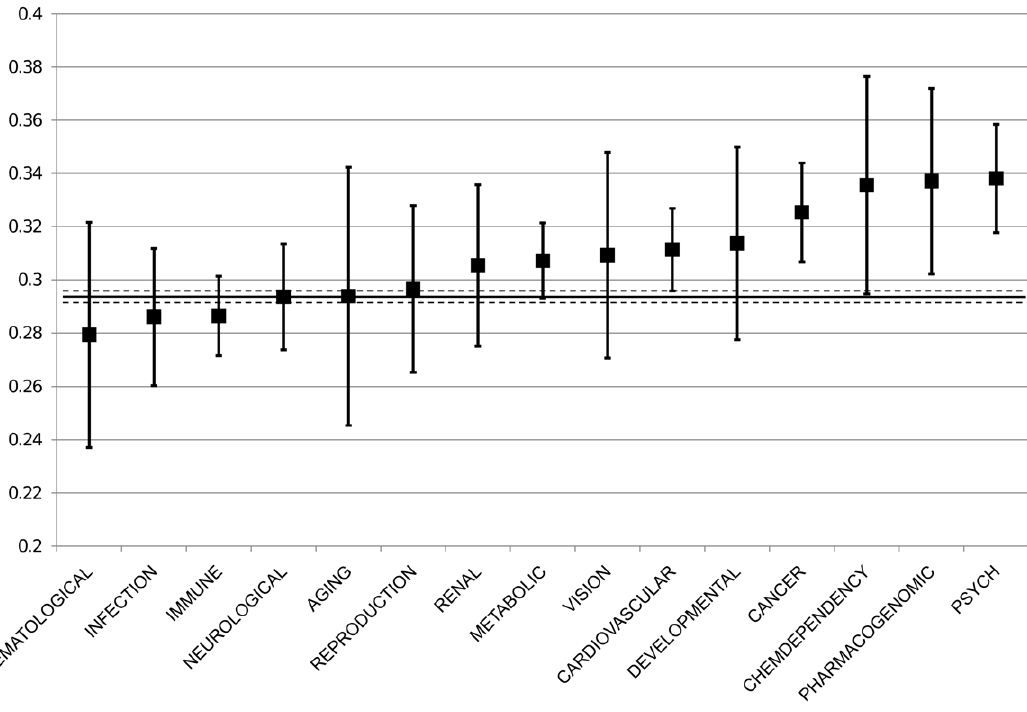
Figure 6. Mean F ST values of genes in different disease classes. Genes were grouped according to the diseases classification of Genetic Association Database. Vertical bars represent 95% confidence interval. Horizontal solid and dashed lines represent mean value and 95% confidence interval of the set of non associated genes.